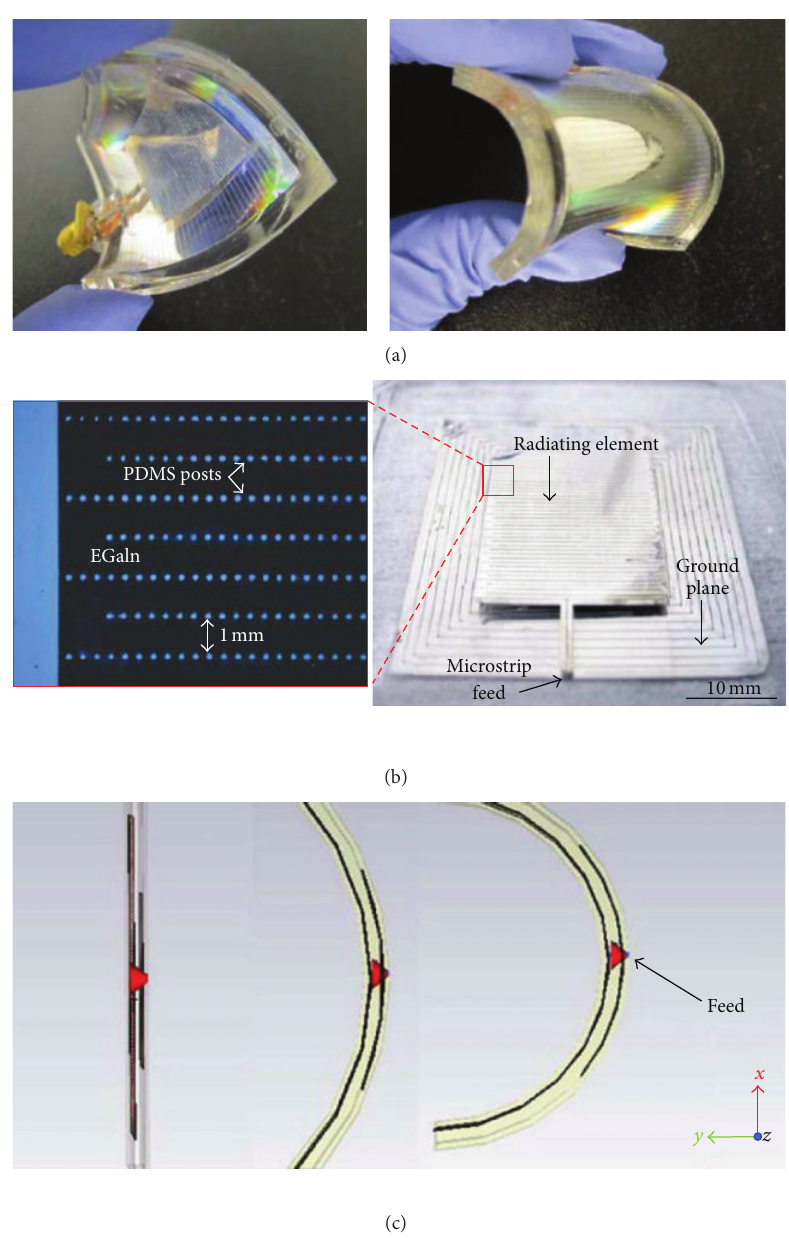
Figure 7: (a) Reconfigurable liquid metal alloy microstrip patch antenna. (b) The patch antenna and ground plane. (c) Cross-sectional view of the conformal configurations: (right) static, (middle) curved to a 25.4 mm radius, and (left) curved to a 12.7mm radius (with permission from